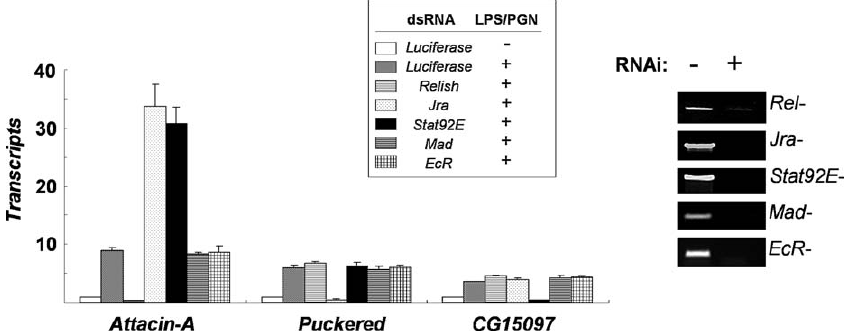
Figure 1. Down-Regulation of Relish Signaling by Stat92E as well as Jra in Response to LPS/PGN Real-time PCR analysis showing LPS/PGN-induced transcriptional activation in various mutant backgrounds. SL2 cells were incubated with dsRNA, as indicated in the top box, for three days. The levels of the transcripts before (-) and after ( þ ) LPS/PGN treatment (10 l g/ml; 1hr) were measured by real time PCR. The degree of depletion of the corresponding transcript by RNAi is shown in the right panel. doi:10.1371/journal.pbio.0050238.g001 PLoS Biology |